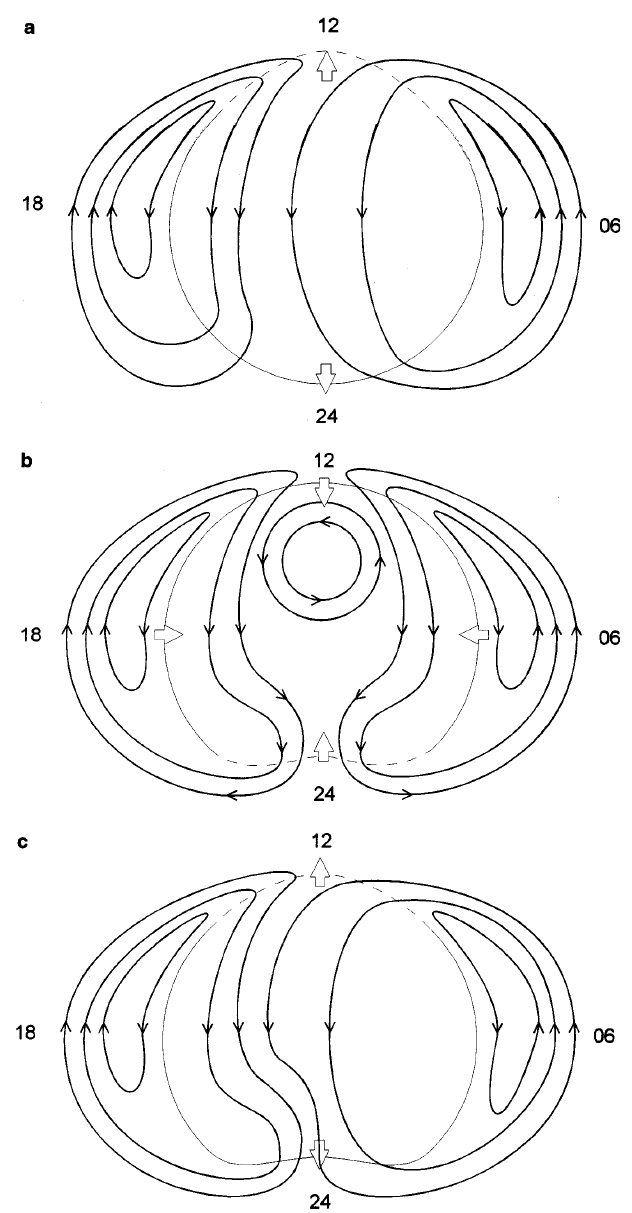
Fig. 14a–c. Schematics of convection patterns and boundary motions during the substorm cycle described based on theoretical models of Lockwood (1990) and Cowley and Lockwood (1992). In each of the three plots, the merging gaps are indicated by dashed lines and the large arrows indicate the boundary movement. a Shows the scene after 2215 UT, when substorm onset signatures were detected and the IMF B field has decreased to ) 20 nT. Although this disturbance may have z involved an interval of reconnection, we infer that no open flux was closed, and hence the polar cap area continues to expand. b Represents the flows after the IMF B has turned northward. A z lobe cell is present – the direction of circulation determined by the negative B field. Enhanced nightside flows are shown driven by tail y reconnection, consistent with the poleward flows detected by the Goose Bay radar at high latitudes. The strong flows are seen in the dayside sector driven by the contraction of the open/closed field line boundary. c Shows the scenario during the substorm recovery phase with the equatorward relaxation of the boundary in the midnight sector, together with the weaker poleward motions elsewhere. Asymmetric flow on the dayside is present as detected by the DMSP Fig. 15. EISCAT and SuperDARN flow vectors at 22:44:51 UT – F10 satellite the time of onset of the poleward flows seen at Goose Bay